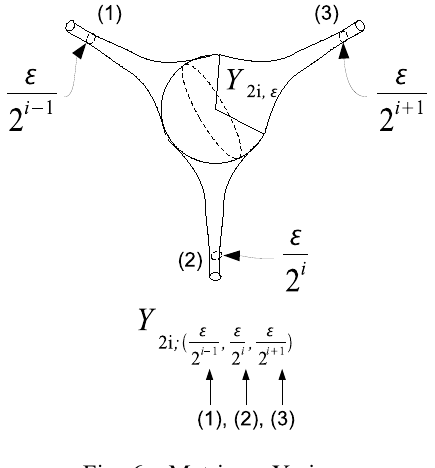
Fig. 6 – Metric on